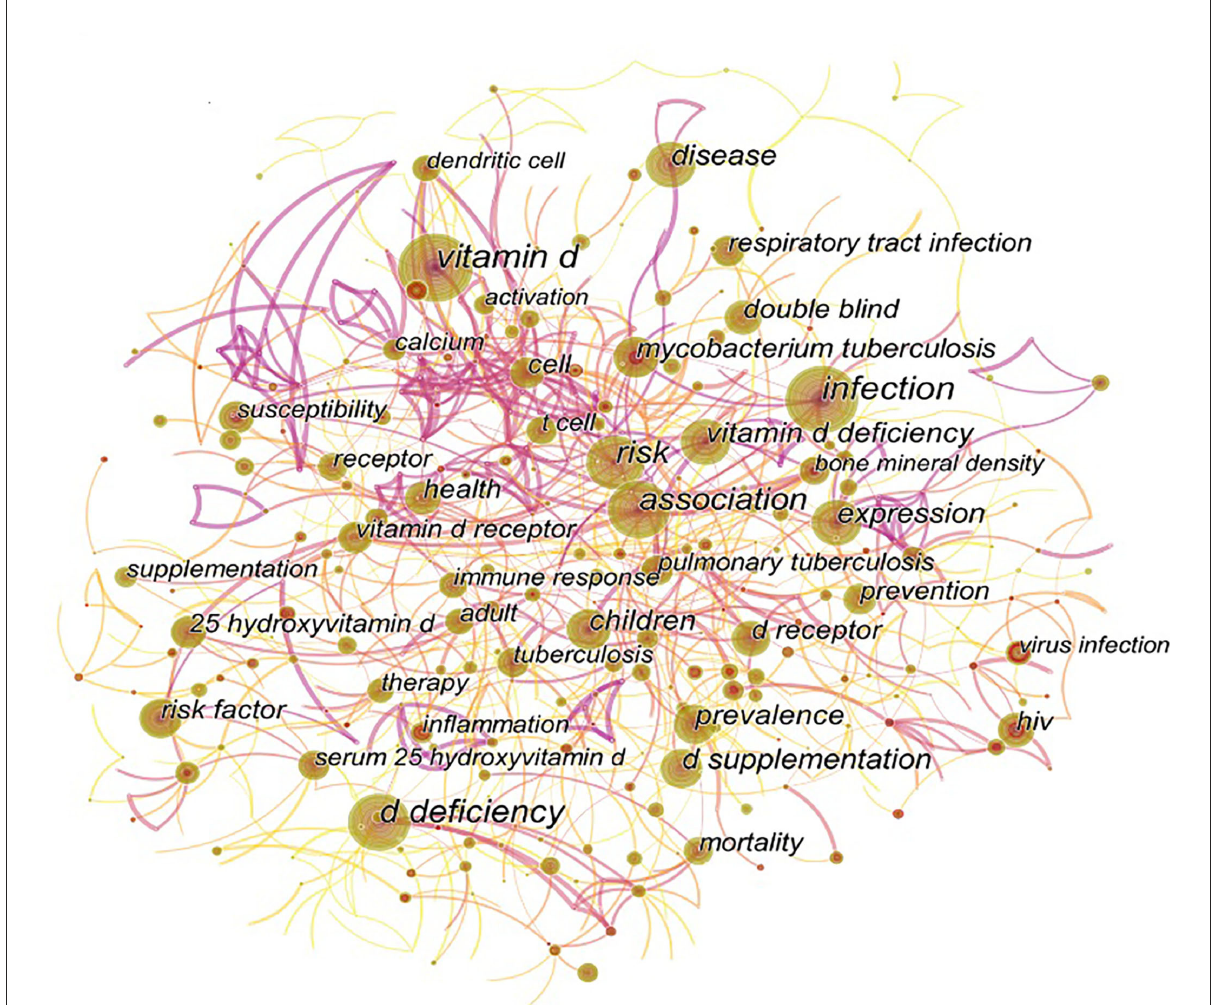
FIGURE4 Keyword co-occurrence network (2001–2021). The nodes represent keywords, and the larger nodes indicate more research articles in that direction. The lines linking the nodes indicate the research connection between keywords, and the thicker the line, the stronger the connection. The top 10 co-occurrence keywords are “vitamin D”, “infection”, “d deficiency”, “risk”, “association”, “expression”, “disease”, “d supplementation”, “vitamin d deficiency”, and